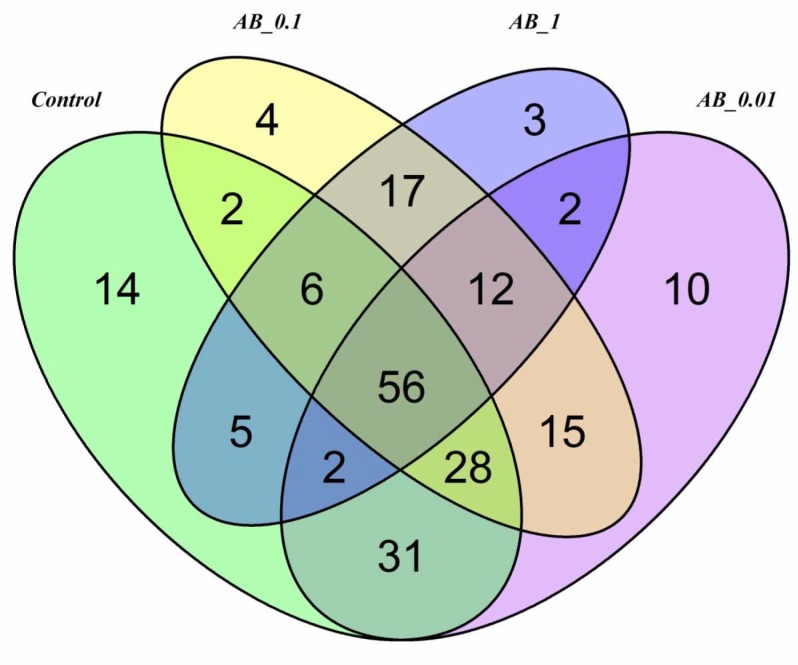
Venn diagram of shared and unique OTUs in the treatments exposed to Ciprofloxacin and in the control.Venn diagram was generated using the rarefied OTUs after applying low count filter of 4 reads with prevalence of 20% in each sample. Shared taxa present in all four groups (100% core threshold) were operationally defined as the core microbiome.